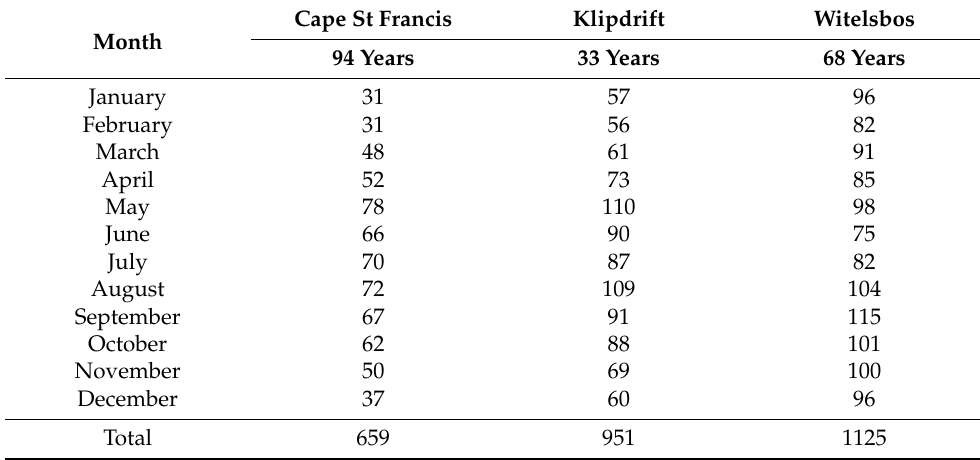
Table 2. Mean long-term monthly rainfall (mm) recorded at Cape St Francis, Klipdrift, and Witelsbos within the Tsitsikamma region